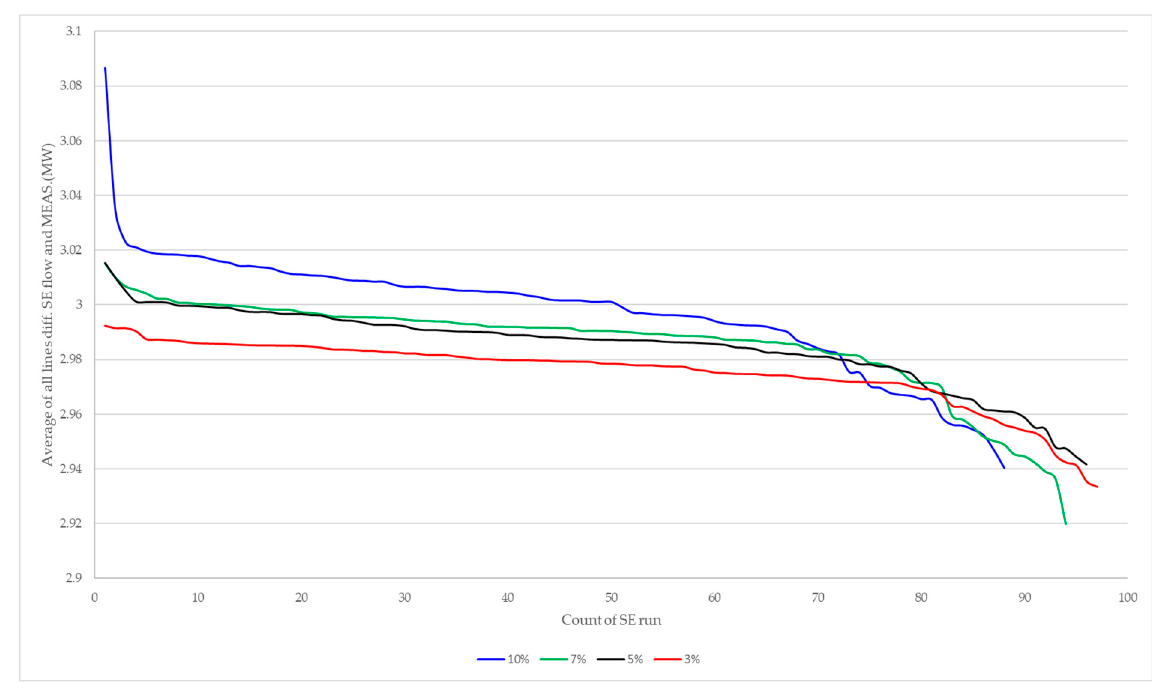
Energies 2021 , 14 , x FOR PEER REVIEW Figure 14. Branch flow between the estimation results and measurements for the SE 100 runs.